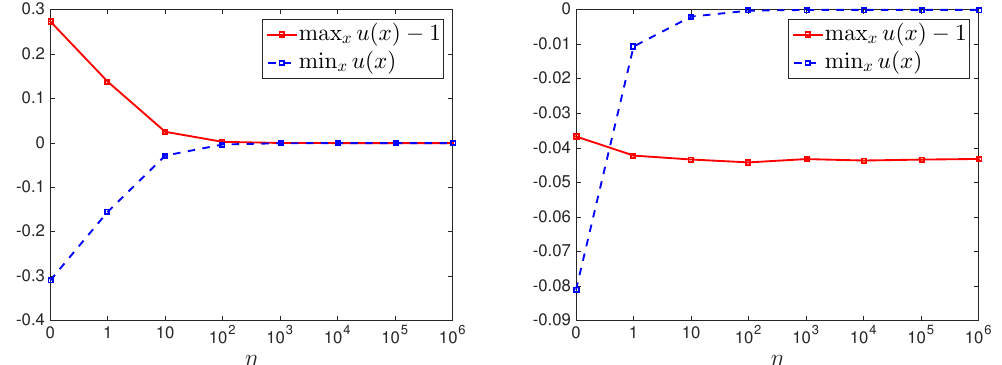
Figure 3. Reconstruction of the cameraman image corrupted by Gaussian white noise with σ = 0.1 ( left ), corrupted by blurring and Gaussian white noise with σ = 0.1 ( right ) via the semi-smooth Newton method with α = 0.01 for different values η